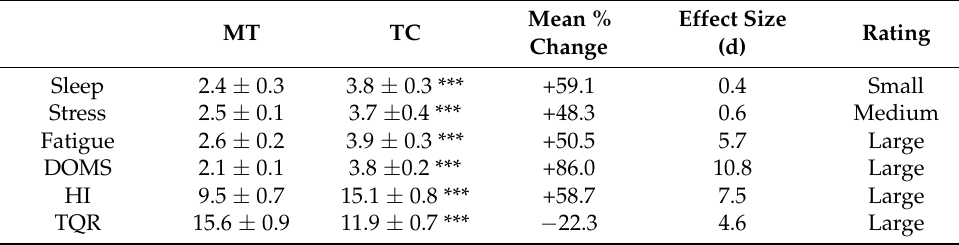
Figure 1. The weekly training load (TL), monotony, and strain during the week of moderate training loads (MT) and the week of intensive training camp (TC), AU: arbitrary units. The gray bars represent means, lines connect values from individual participants from MT to TC. Paired t test, n = 15. **** p < 0.0001. Table 4. The averageratings of sleep, stress, fatigue, DOMS, Hooper index (HI) and total quality of recovery (TQR), throughout the weeks of moderate training (MT) and intensive training camp (TC) (values are mean ± SD; n = 15).